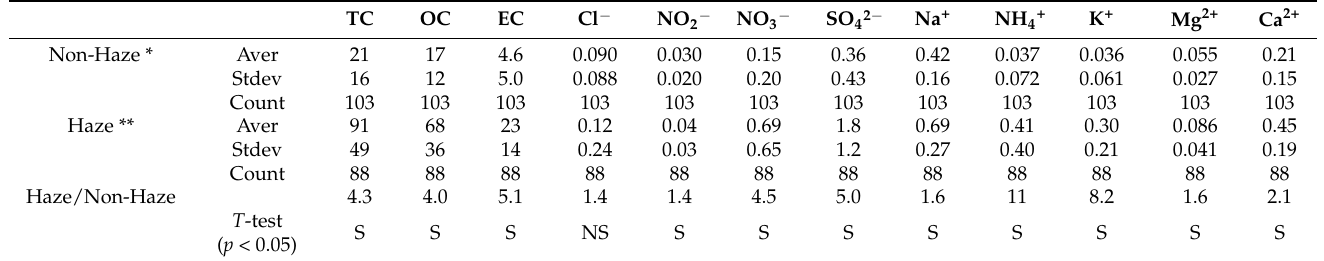
Table 3. Statistical description of carbonaceous aerosols and WSIS in PM 2.5 collected at COS, BOS, and POS during the non-haze and haze